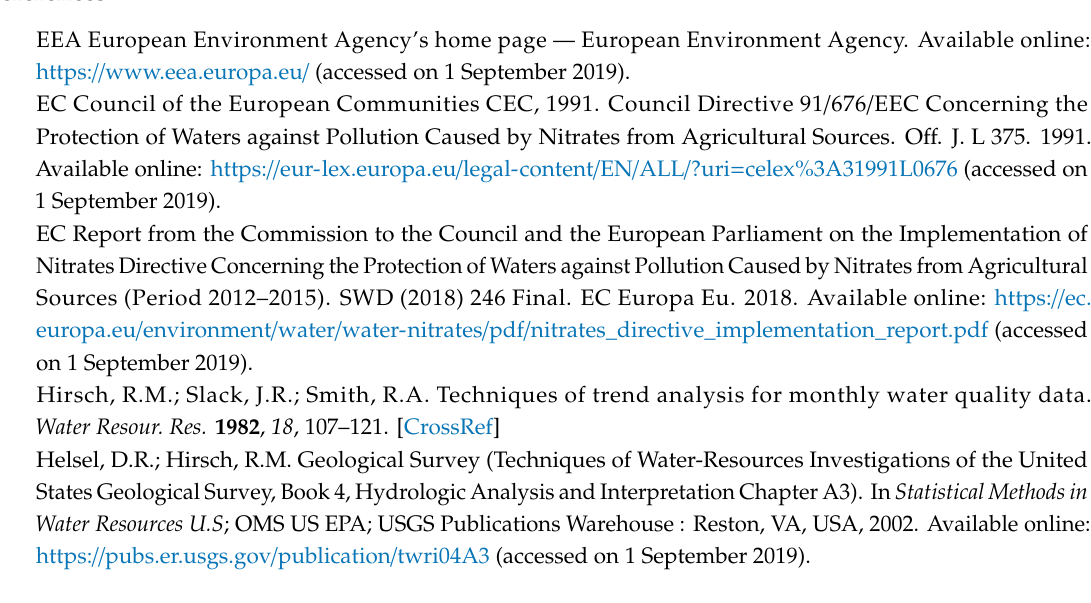
s1, Figure S1: Gross nitrogen surplus for France for the period 2000–2018 (Eurostat). Figure S2: Predicted change in NO 3 concentration (mg / L) for the period 1991–2017 using the flow-weighted concentration. Figure S3: Predicted change in NO 3 concentration (mg / L) due to management for the period 1991–2017 as predicted by WRTDS (removal of the random and systematic flow variations). Figure S4: Predicted change in NO 3 concentration (mg / L) due to flow for the period 1991–2017 (di ff erence between the total absolute change and the change due to